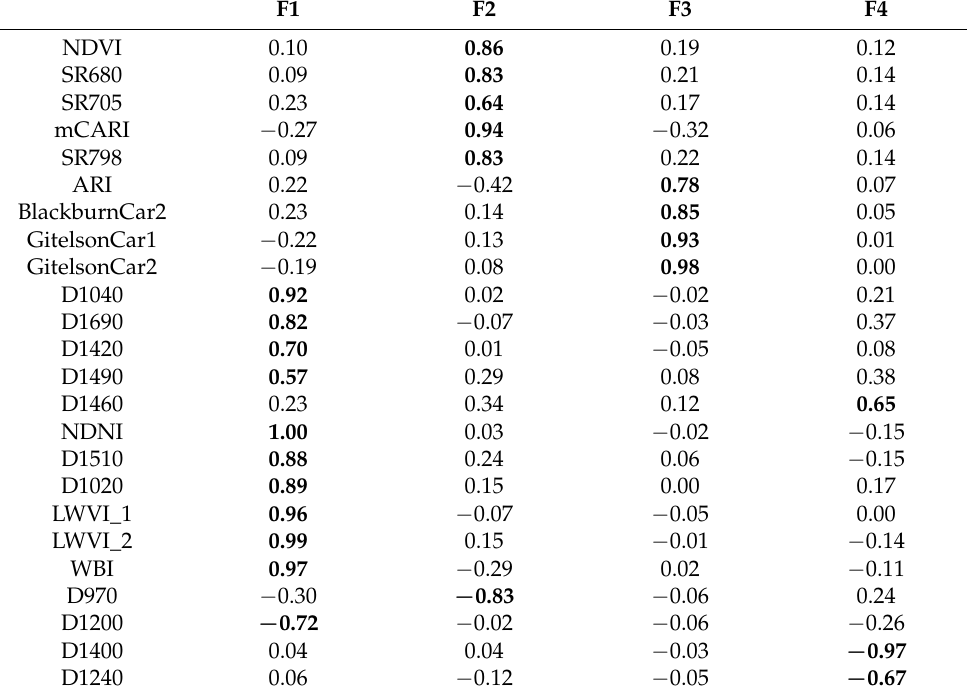
Table 2. Factor loadings. Strong loadings on a factor are printed in bold, indicating the strength and direction of the impact of the optical metric on the respective factor Factors F1 to F4 explained 38%, 21%, 16%, and 12% of the variance, respectively. The loadings of F1 were strong for optical metrics related to carbohydrates, nitrogen, and water, whereas F2 loadings were strong for optical metrics related to photosynthetic pigment concentration and productivity. Optical metrics related to photo-protective pigments showed especially strong loadings on the F3 factor, whereas the F4 factor was mostly determined by optical metrics related to leaf water, phenolic compounds, and heavy metal